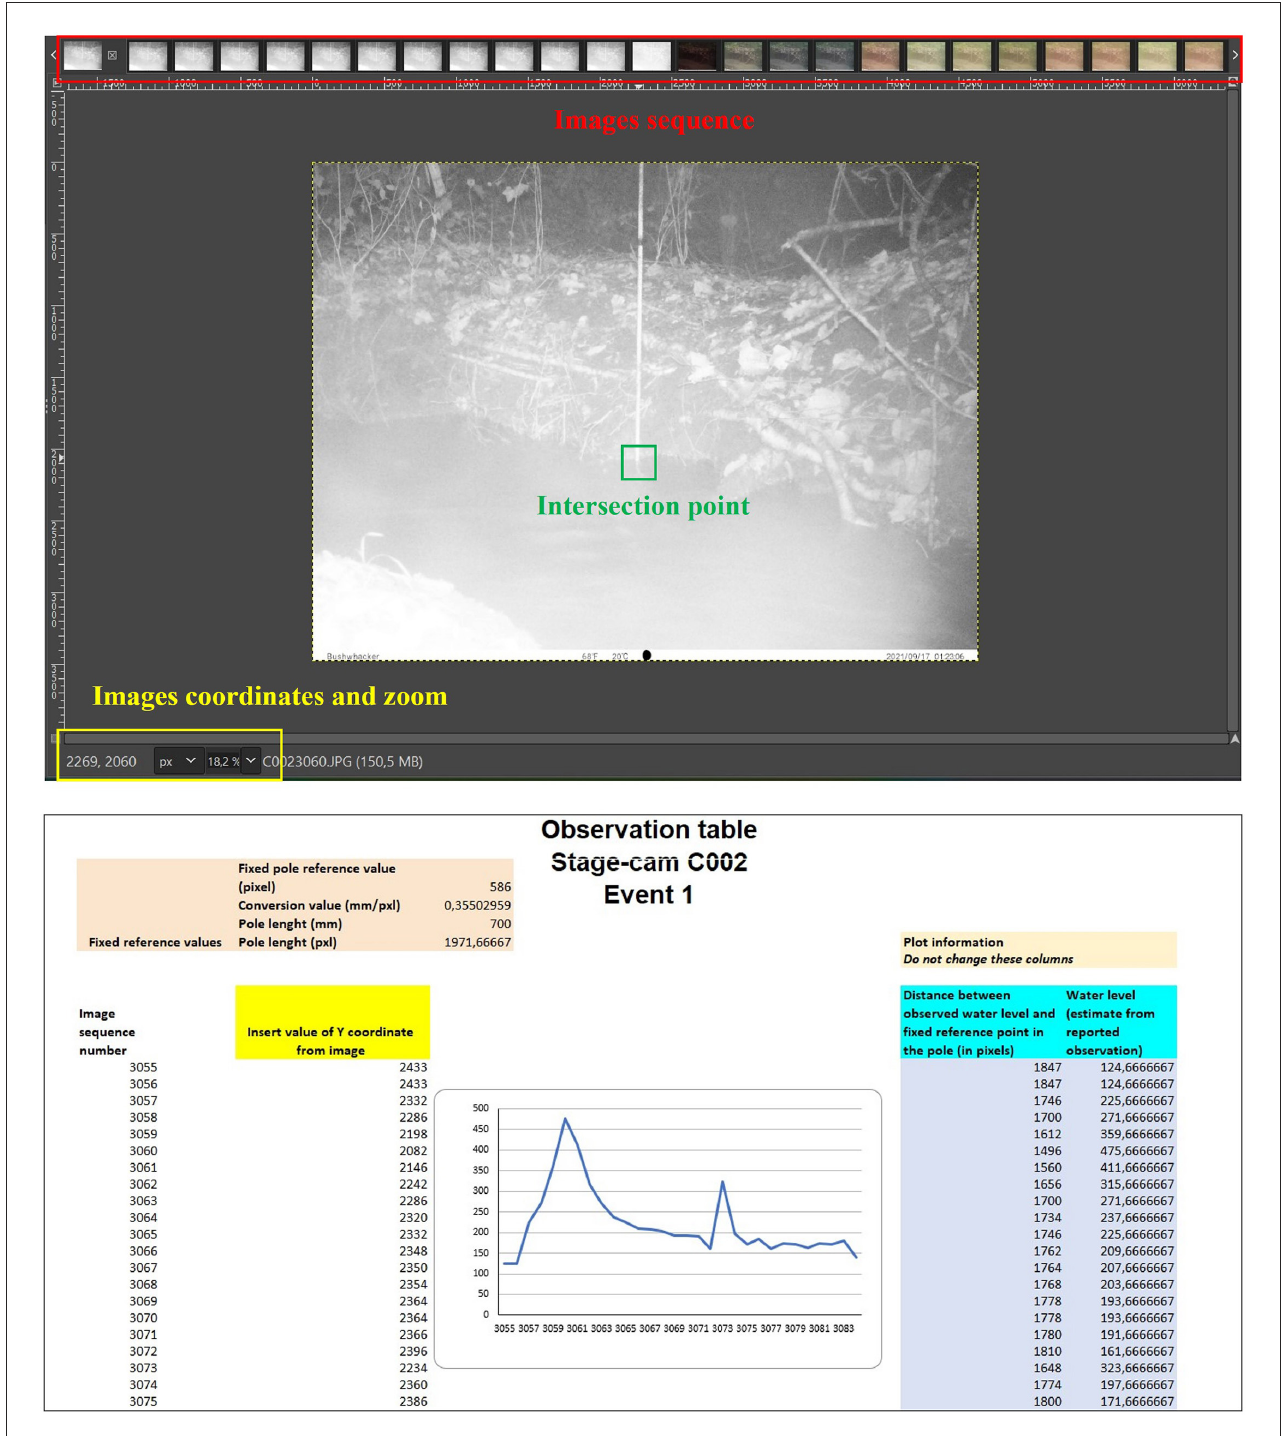
FIGURE3 Working environment for data collection and observations recording: (upper figure) A screenshot from GIMP displays the time series of 30 images related to stream water levels; (lower figure) The observation table shows values provided from image visualization by